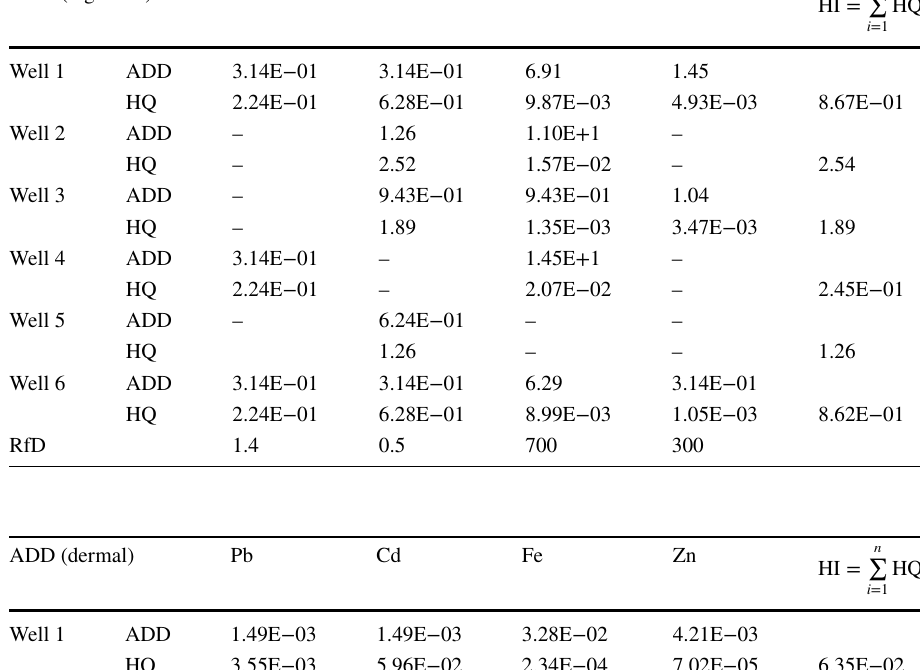
Table 4 Non-carcinogenic health risk for heavy metals in the well water samples from the Anloga community through oral exposure